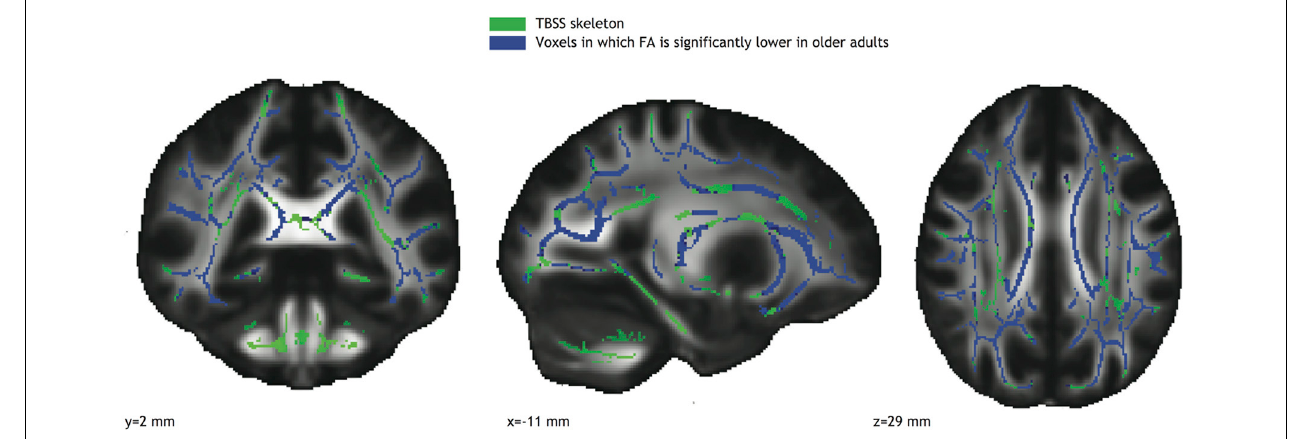
FIGURE 2 | Voxels with significantly reduced FA in the older adults group (blue; TFCE corrected) overlaid on the TBSS skeleton (green).